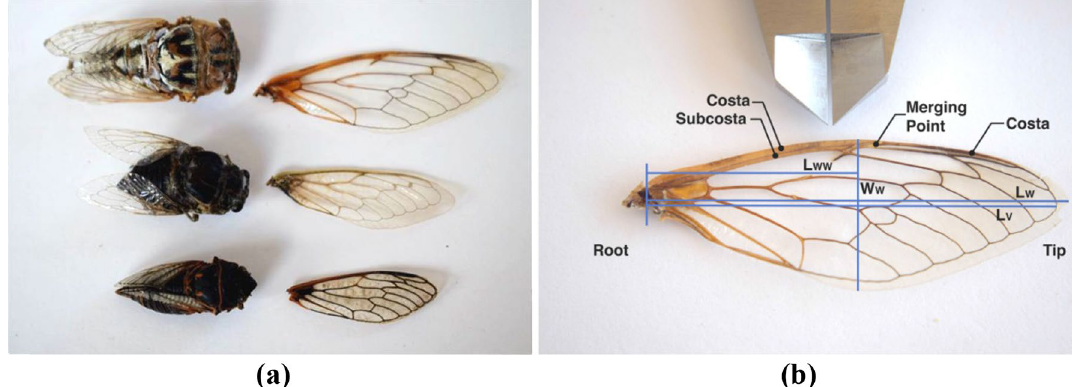
Figure 1. Cicadas considered in the study with one of their removed forewings displayed to the right. Images: ( a ) the species used in the study from top to bottom: Megatibicen dealbatus, Cacama valvata , and Tibicen duryi, ( b ) the characteristic parts and dimensions of a cicada’s wing.